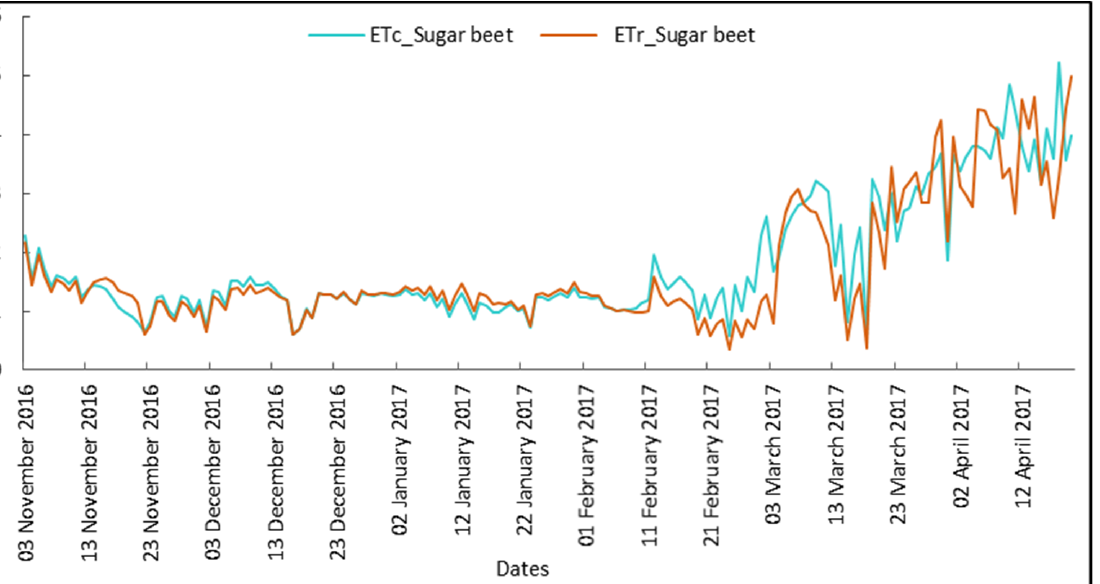
Figure 14. Comparison between ETc and ETr for cereal crops (wheat and barley) .